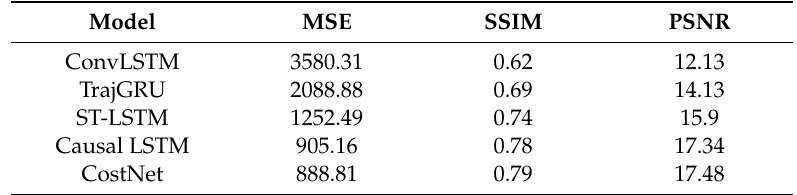
Table 2. A comparison of di ff erent models for predicting 10 frames on the radar dataset.